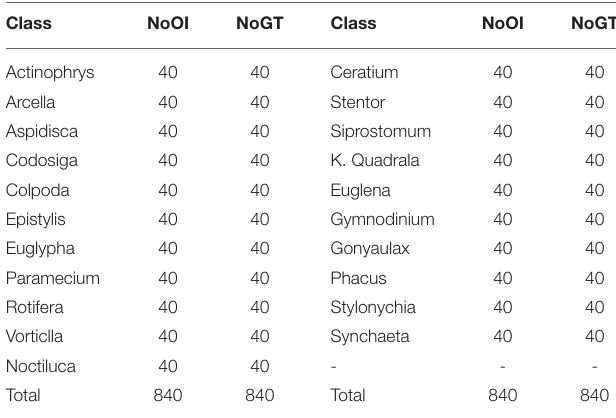
TABLE 1 | Basic information of EMDS-6 dataset, including Number of original images (NoOI), Number of GT images